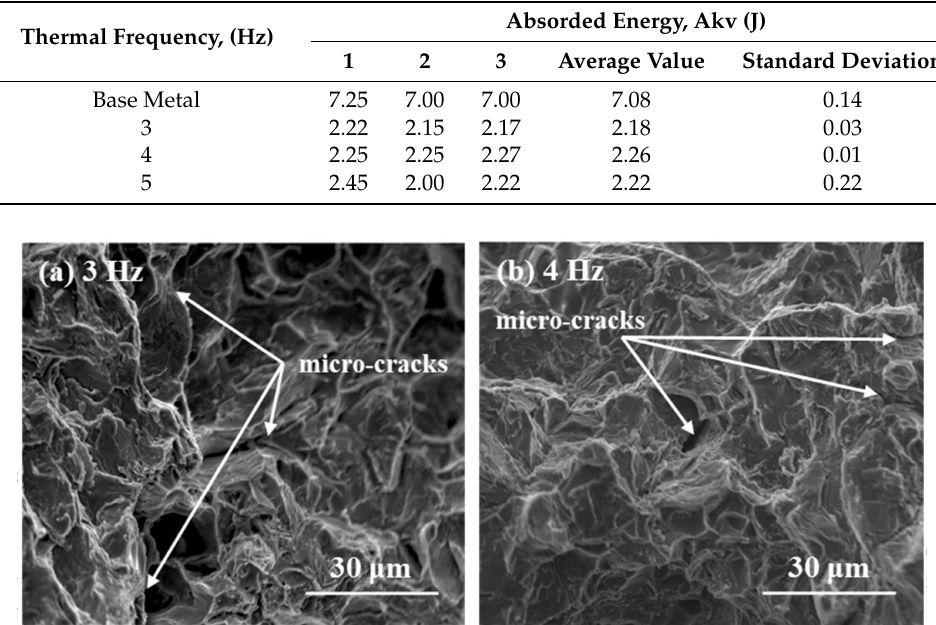
Table 4. Impact properties of the base metal and welded joint.